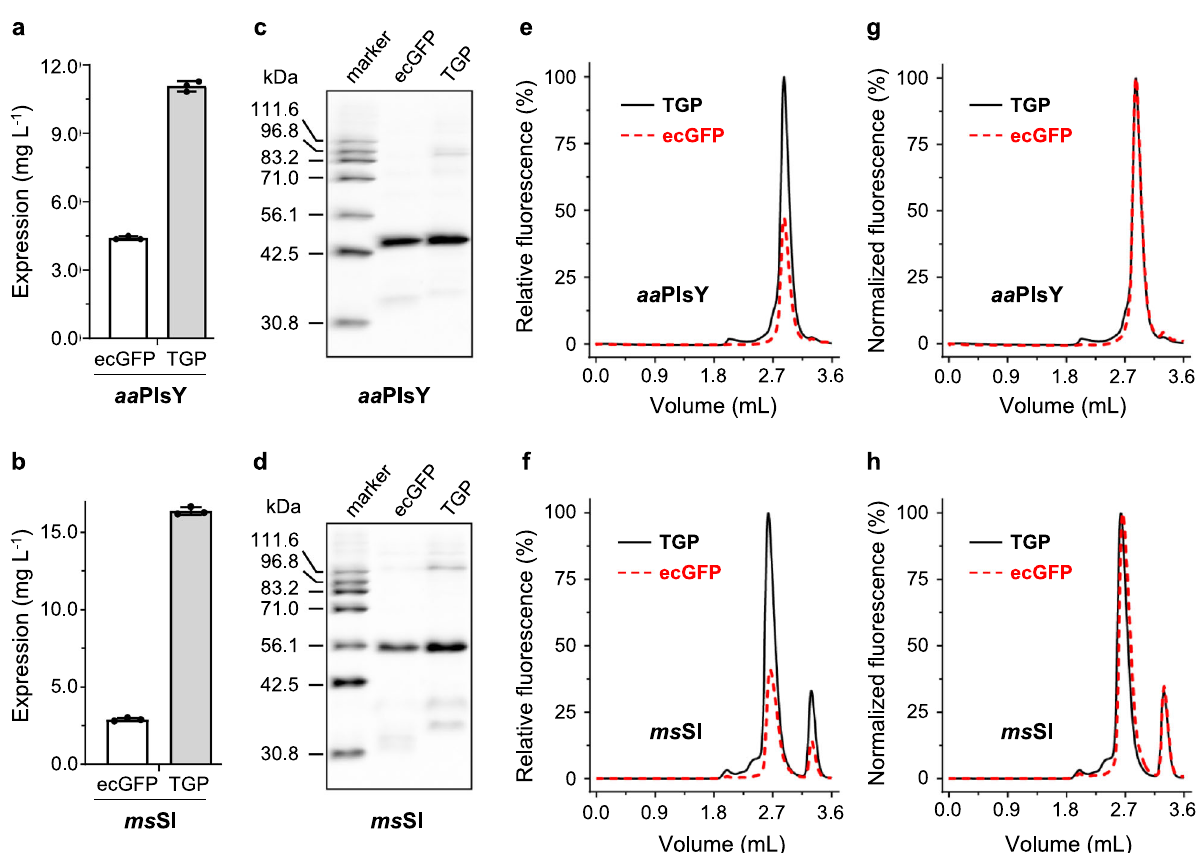
Fig. 3 Replacing GFP with TGP improved expression of aa PlsY and ms SI in E. coli . Assessment of expression level was based on fl uorescence